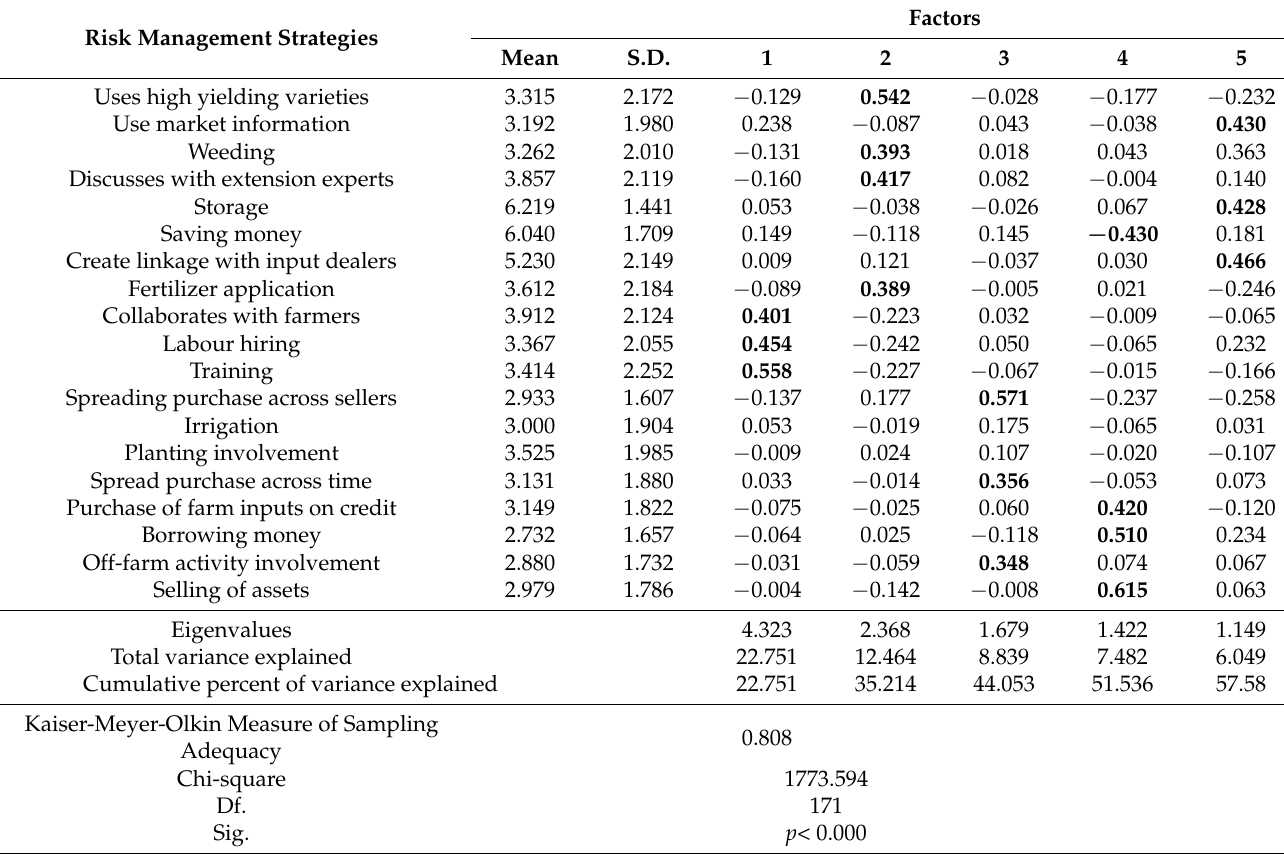
Table 3. Factor analysis output for input risk management strategies.